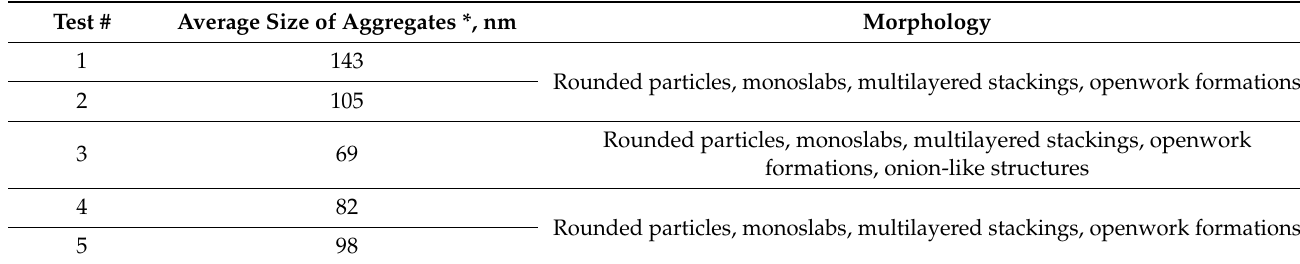
Table 5. The characteristics of Mo-containing aggregates in polycondensation solids according to TEM study. Test # Average Size of Aggregates *, nm